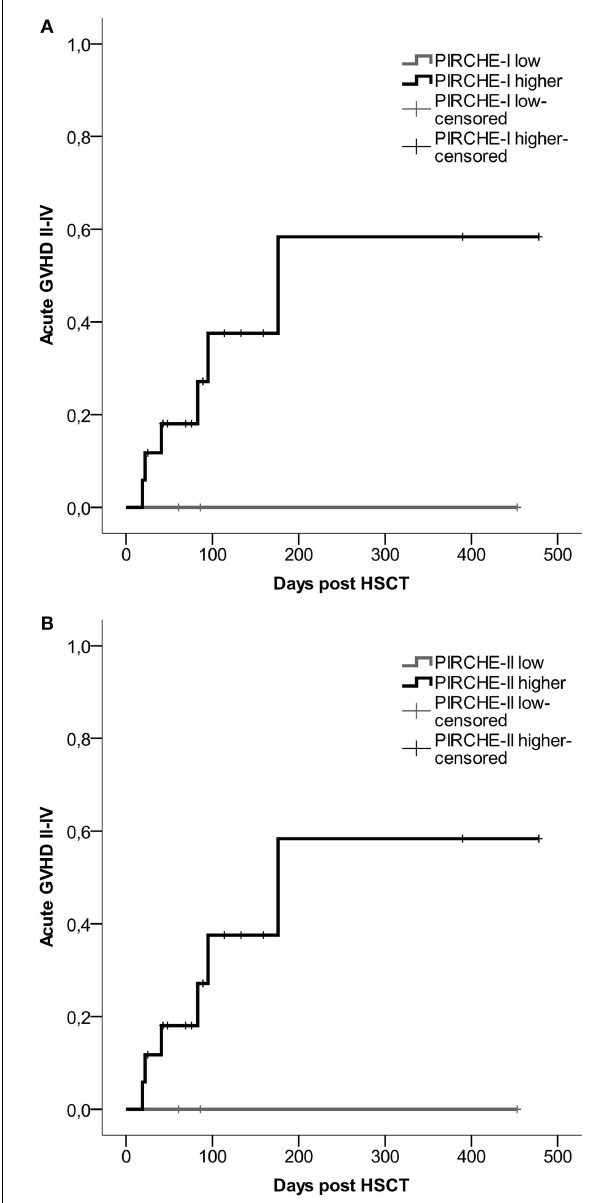
FIGURE 3 | (A) Probability of acute GVHD by HLA-C-derived PIRCHE-I low or PIRCHE-I higher. (B) Probability of acute GVHD by HLA-C-derived PIRCHE-II low or PIRCHE-II higher. Kaplan–Meier curves were constructed to analyze the probability of developing acute GVHD II-IV for patients in the low (in gray) and higher (in black) PIRCHE groups. Patients with low PIRCHE-I did not develop acute GVHD. Patients with low PIRCHE-II did not develop acute GVHD. Probabilities of acute GVHD II-IV were not significantly different amongst the low or higher PIRCHE groups as tested with log-rank tests. GVHD: graft-versus-host disease; HSCT: hematopoietic stem-cell